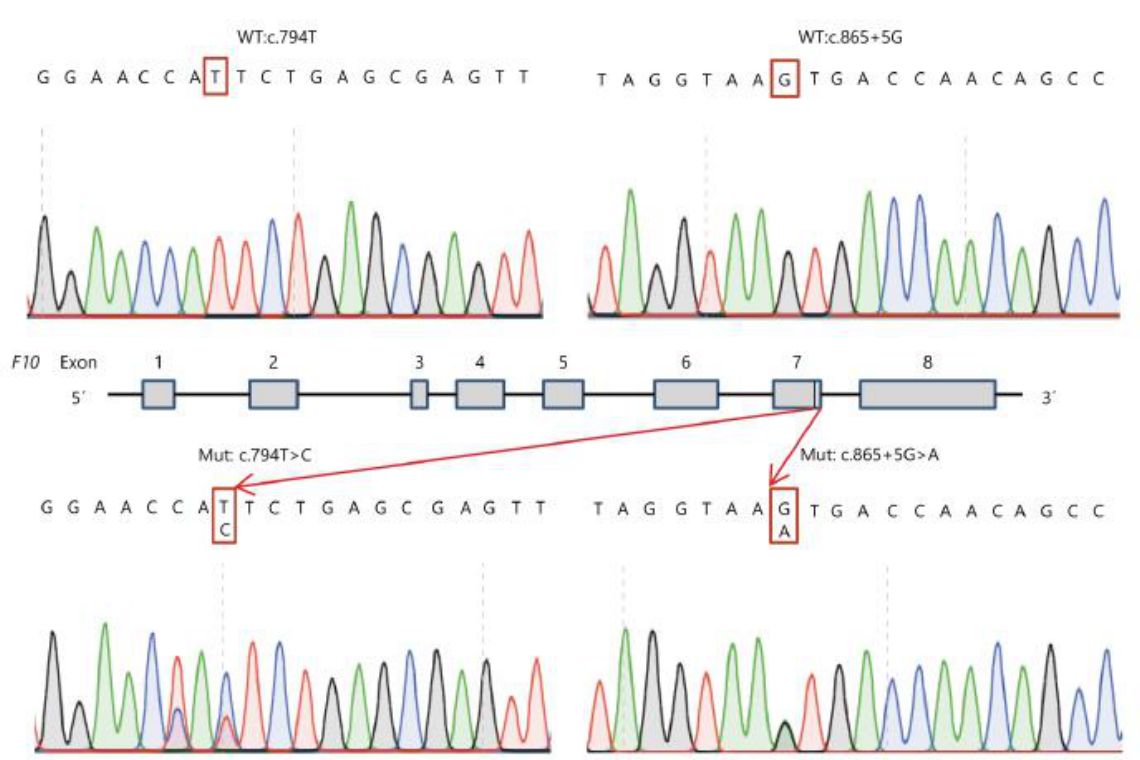
Figure 2. Sequencing analysis of the family. The proband has two types of mutation in exon7 and intron7: c.794T > C and c.865 + 5G > A. The analysis identified heterozygous mutations with c.794T > C in his father and twin sons and with c.865 + 5G > A in his mother, sister, niece and elderly son. WT = wild type, Mut = mutation. Table 1. Demographics and coagulation parameters of the proband and family